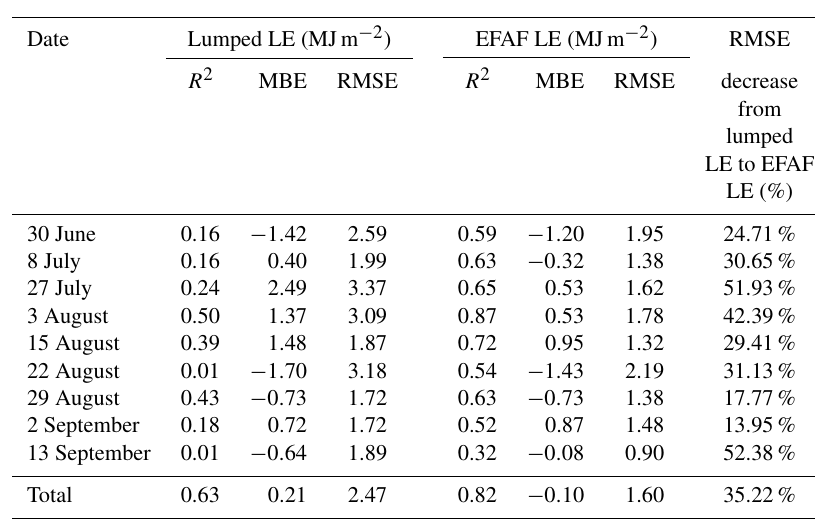
Figure 6. Maps of (a) lumped EF, (b) EFAF EF, (c) difference between EFAF and lumped EF (EFAF EF minus lumped EF), (d) lumped daily LE, (e) EFAF daily LE and (f) difference between EFAF and lumped LE (EFAF LE minus lumped LE) on 22 August 2012. Table 3. In situ validation results for the daily